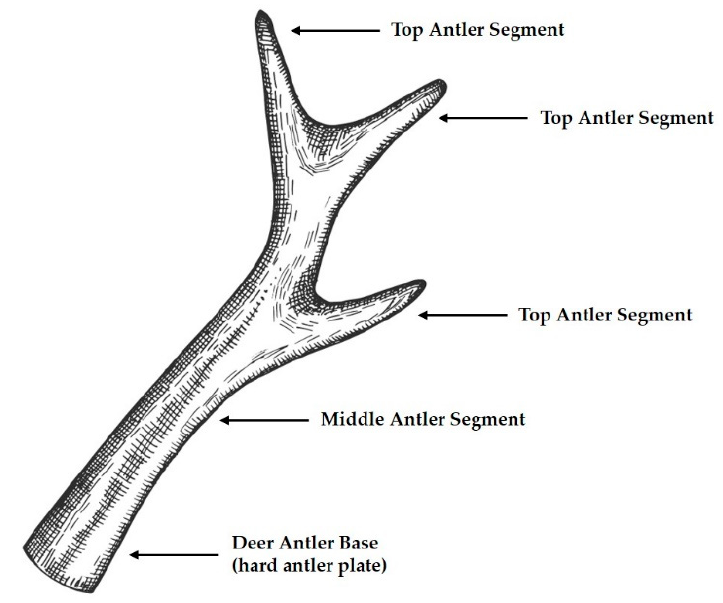
Figure 1. Parts of Deer antler. Table 1. Chemical compositions of different sections of Deer antler.